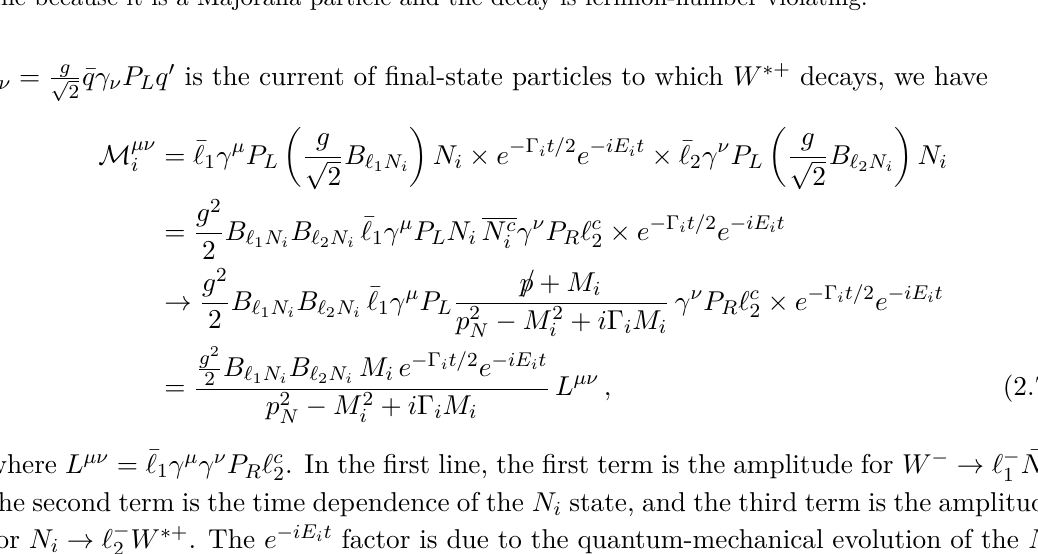
Figure 1 . Diagram for W − → ‘ − line because it is a Majorana particle and the decay is fermion-number